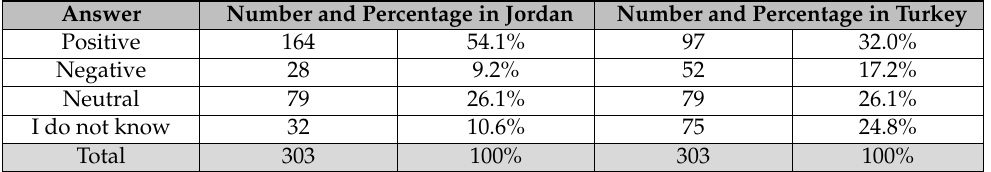
Table 3. The Participants Opinions on The Image Projected On Social Media About Syrian